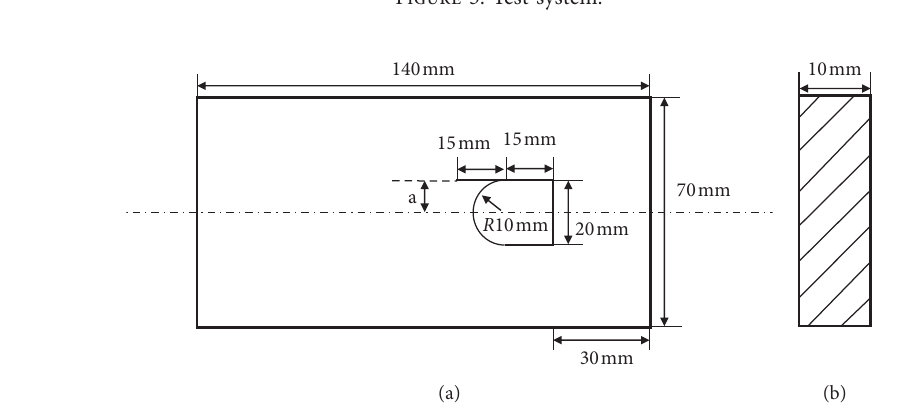
Figure 5: Test system.